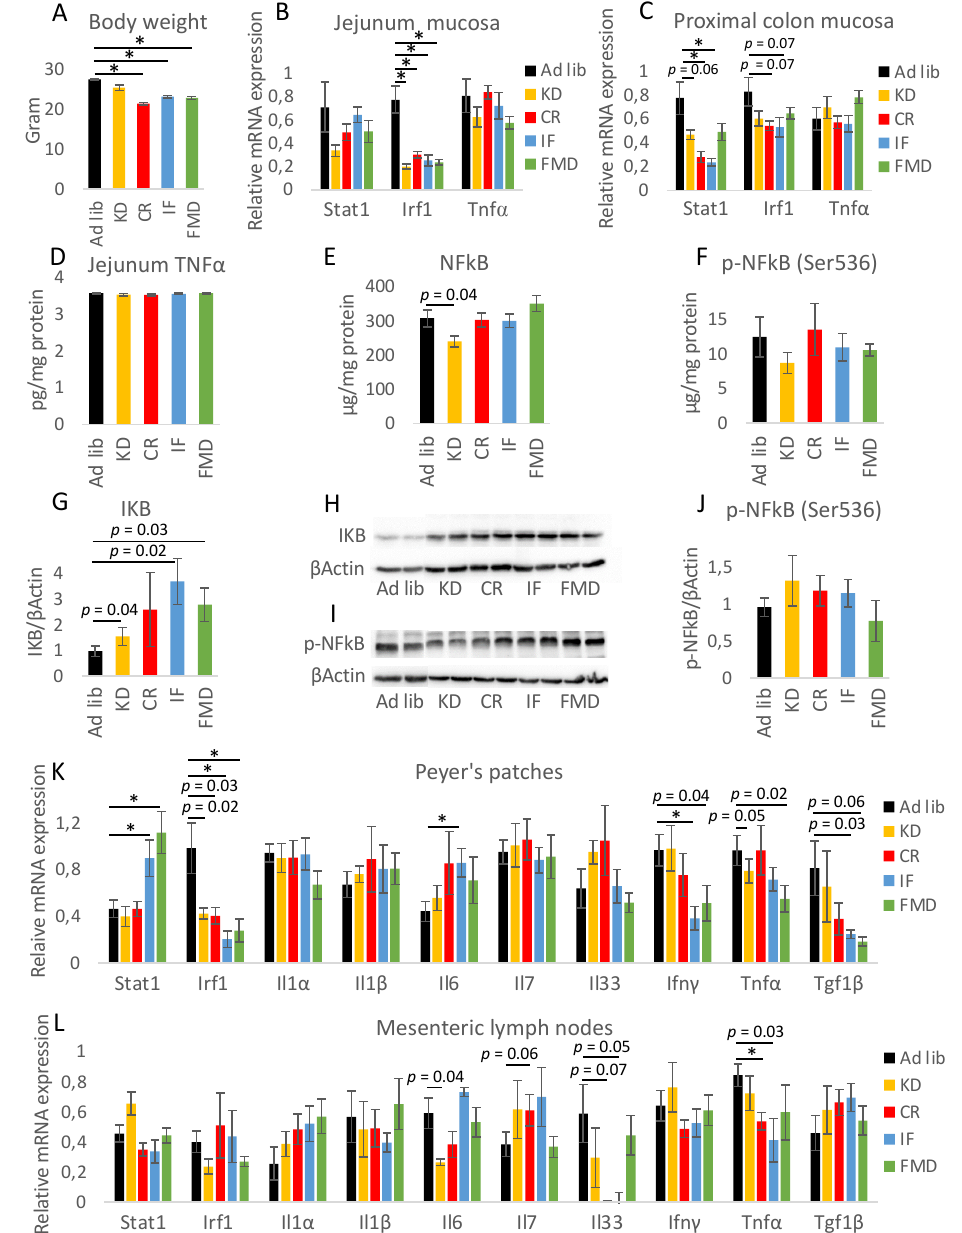
Figure 1. Restrictive diets reduce the expression of inflammatory factors in the gastrointestinal (GI) tract. Bodyweight was verified on the last day of the experiment ( A ). Gene expression of inflammation-related genes was measured in the mucosa of the jejunum ( B ) and proximal colon ( C ). The protein level of TNF α ( D ), NF κ B ( E ), phosphorylated NF κ B ( F , I , J ), and IKB ( G , H ) was